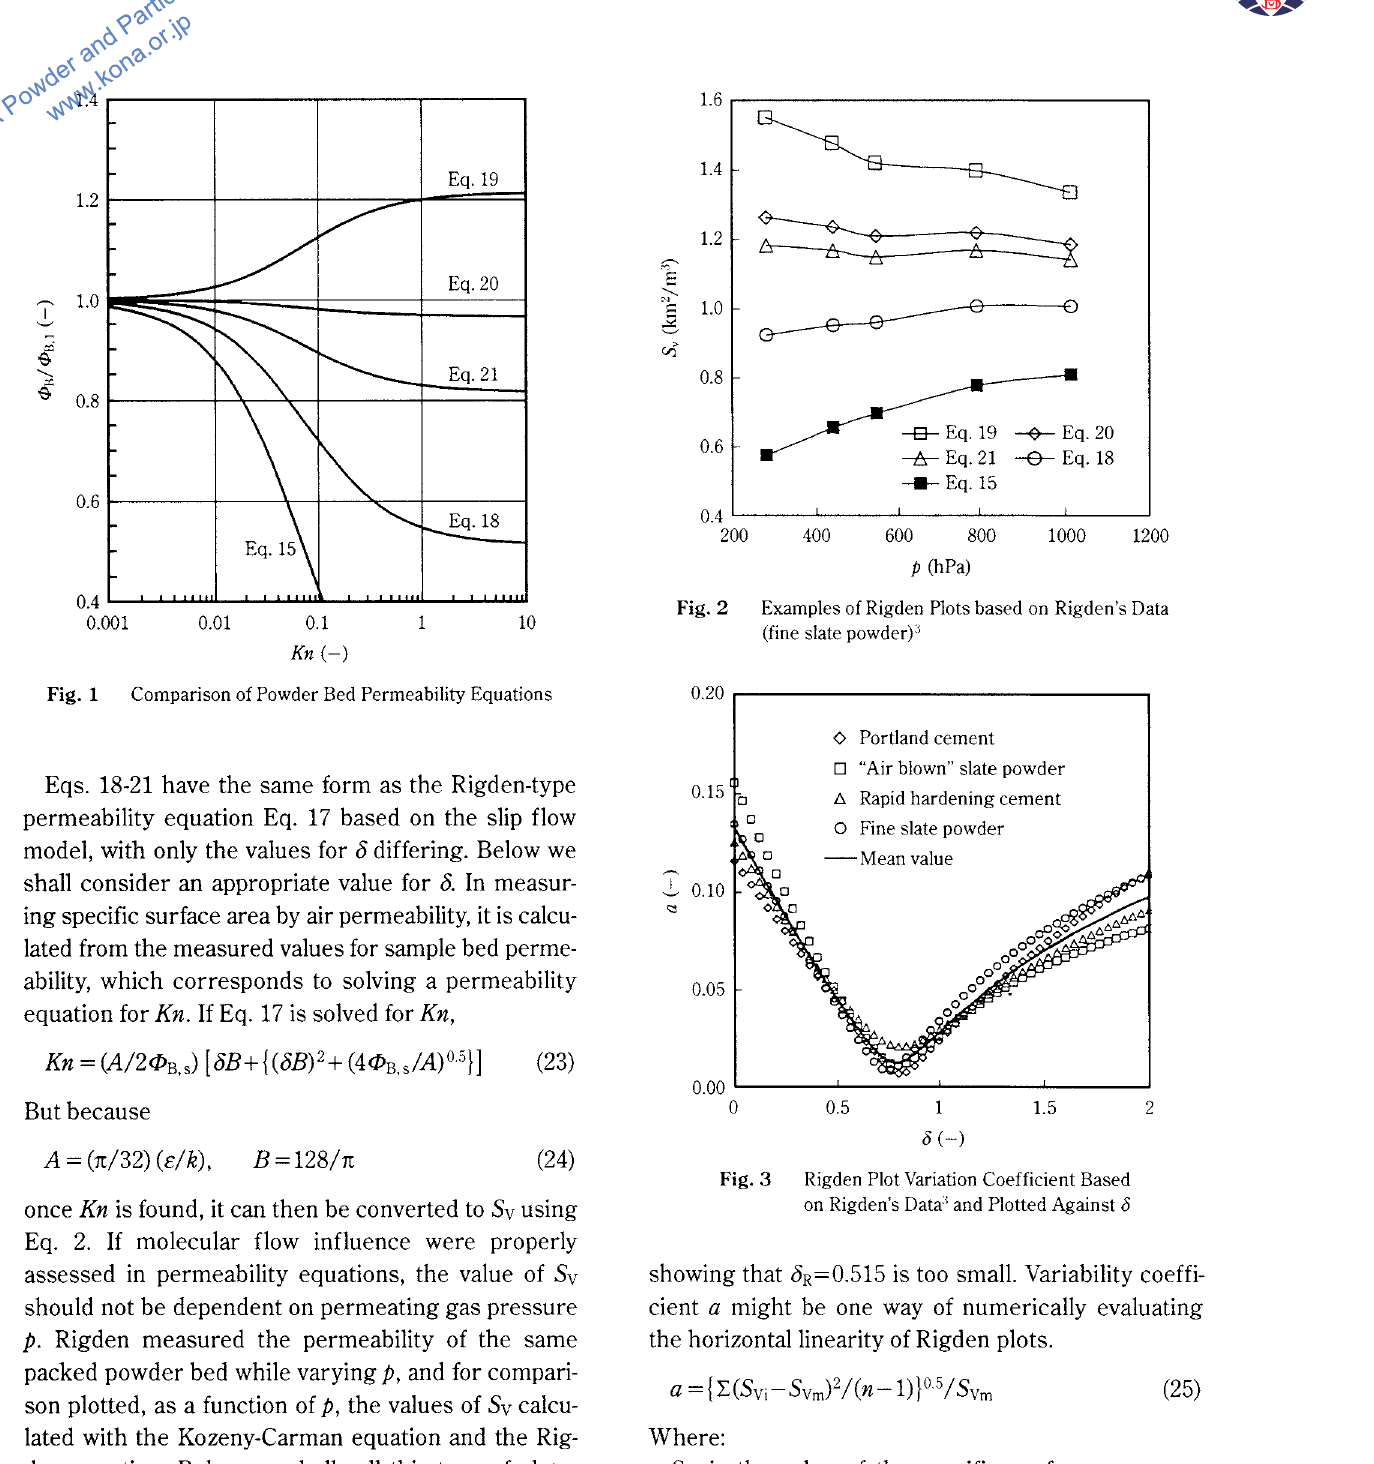
Fig. 3 Rigden Plot Variation Coefficient Based on Rigden's Data" and Plotted Against c5 showing that 8R=0.515 is too small. Variability coeffi cient a might be one way of numerically evaluating the horizontal linearity of Rigden